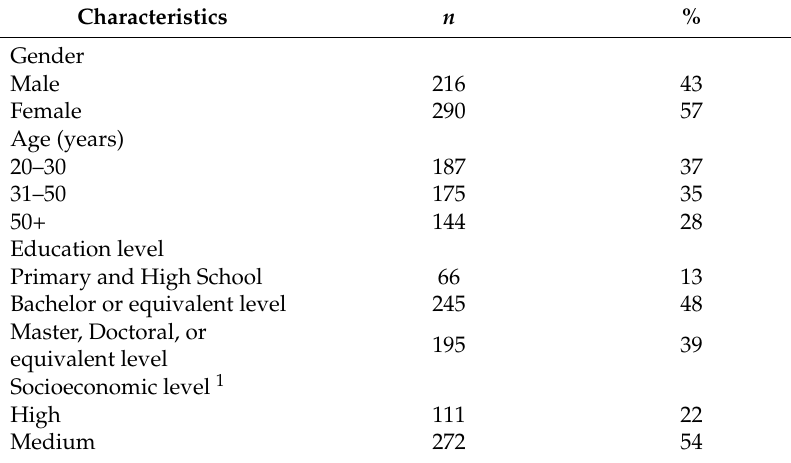
Table 1. Sociodemographic characteristics and percentage of energy provided by macronutrients among adults in an urban population. Brazil,